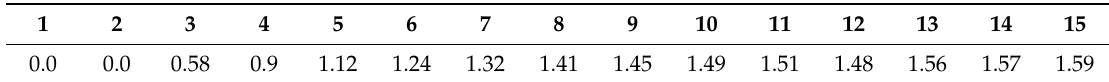
Table 6. Random Index (RI)